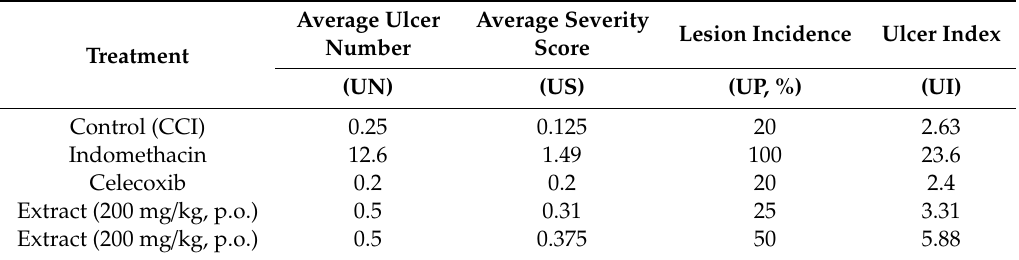
Table 4. Chronic ulcerogenecity of S. tetrasperma extract as compared to two reference drugs celecoxib and indomethacin.